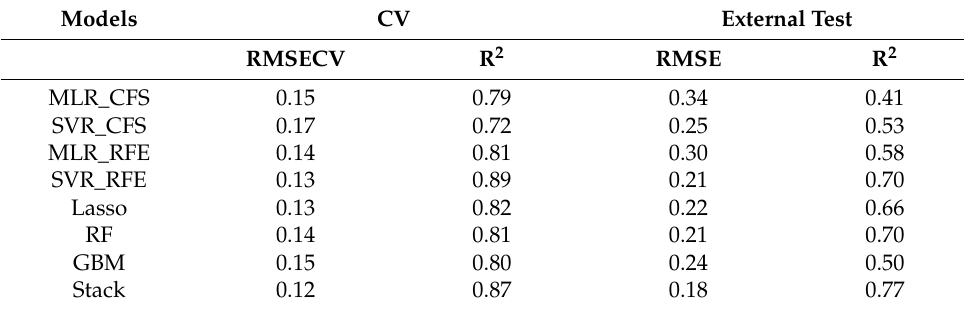
Table 2. Prediction performances of all models at pH 3.5.